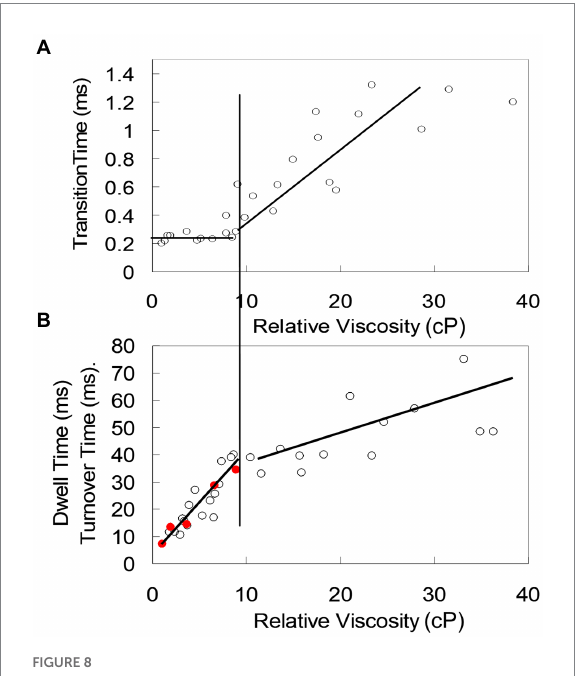
FIGURE 8 Interdependence of catalytic dwell duration, ATPase activity, and average transition time (time required for the power stroke to rotate 90 ° ) as a function of load on the Ec F 1 motor. (A) Transition time vs. viscosity. (B) Catalytic dwell duration ( ○ ) and ensemble ATPase activity measured as k cat ( ● ) vs. viscosity. Load on the motor was varied by increasing concentration of PEG-400, which increased the viscous drag on the AuNR attached to subunit- γ . At loads <4 aN nm ms (vertical line between A and B ), transition time is constant (not load-limited) while catalytic dwell time and k cat show the same proportional increase with drag. At loads >4 aN nm, both transition time and catalytic dwell time increase proportionately with load. These data were reconfigured from those in Spetzler et al.